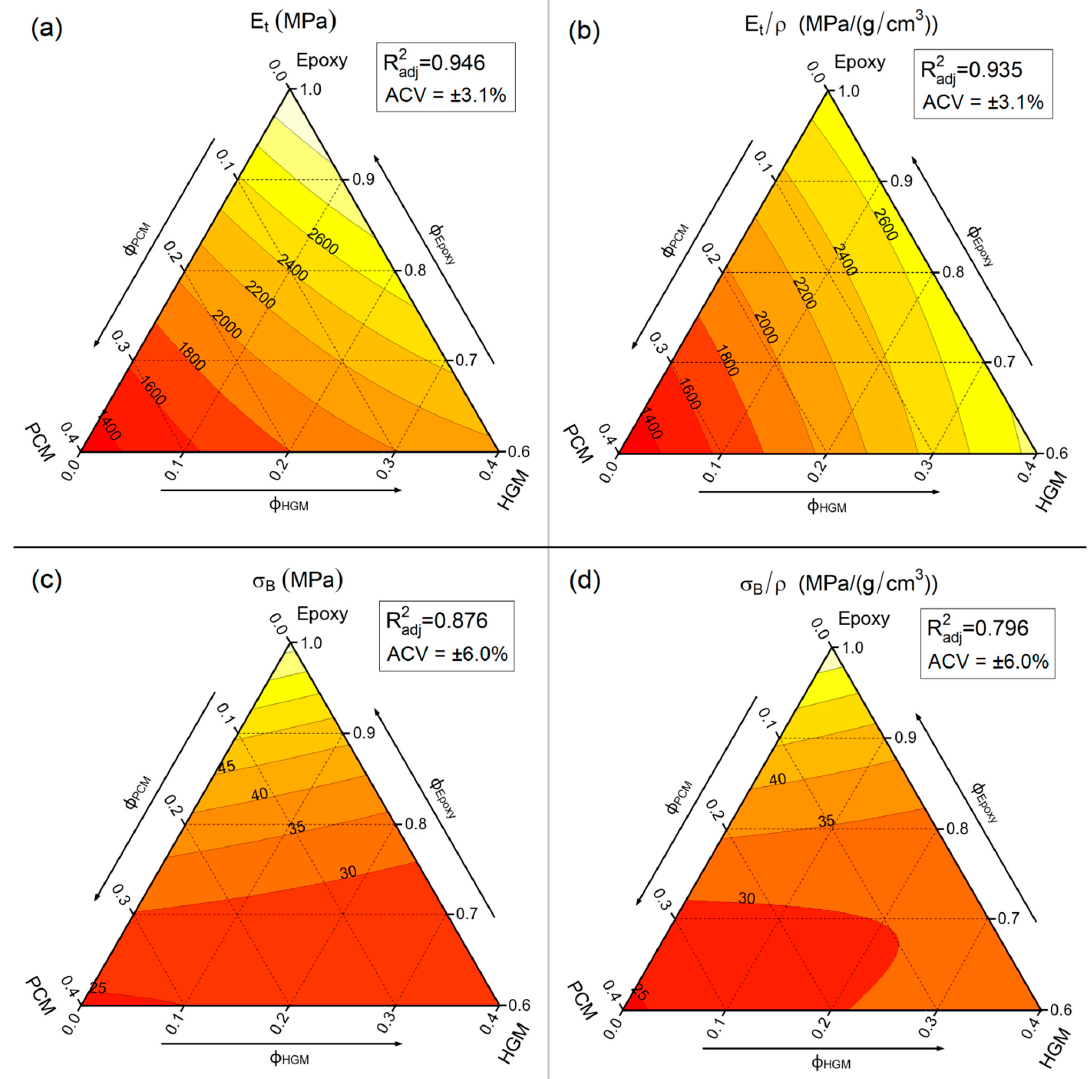
Figure 3. Fit-models of the main results of quasi-static tensile tests of the prepared syntactic foams. ( a ) Young’s modulus (E t ); ( b ) specific Young’s modulus (E t / ρ ); ( c ) tensile stress at break ( σ B ); and ( d ) specific stress at break ( σ B / ρ ). R 2adj = adjusted R-squared, ACV = average coefficient of variance.